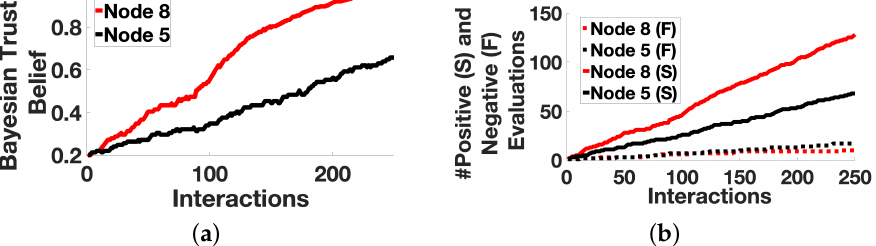
Figure 3. Bayesian trust belief evaluation ( S : positive, F : negative evaluations). ( a ) Trust Belief vs. Interactions, ( b ) Evaluations vs.